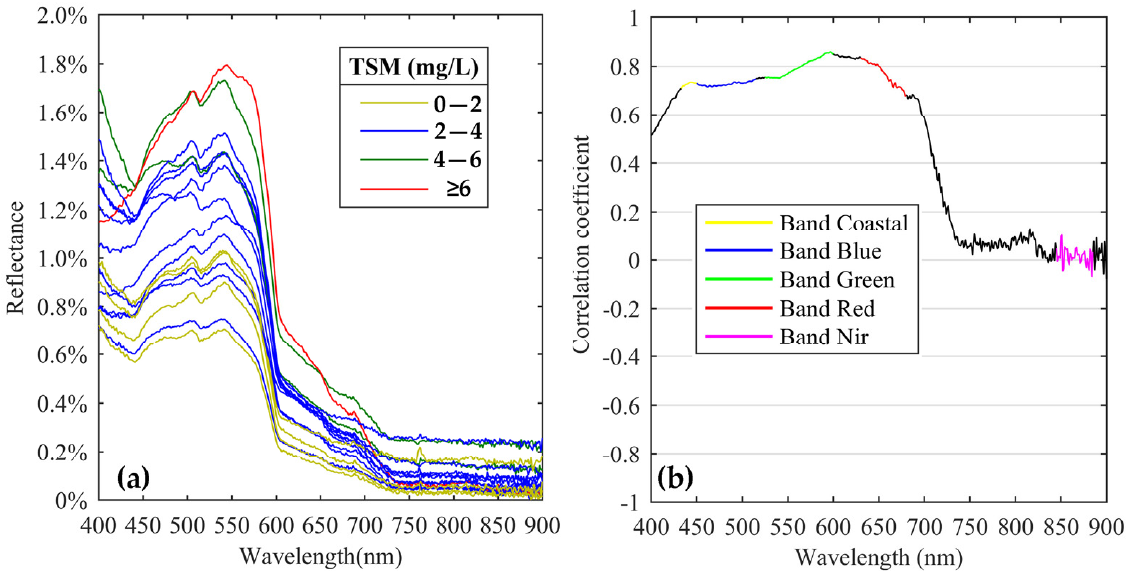
Figure 3. Spectral analysis results: ( a ) reflection spectrum curve of Lake Qinghai; ( b ) correlation coefficient between in-situ reflectance and TSM concentration correction, and different colors correspond to different bands of Landsat 8 OLI sensor.